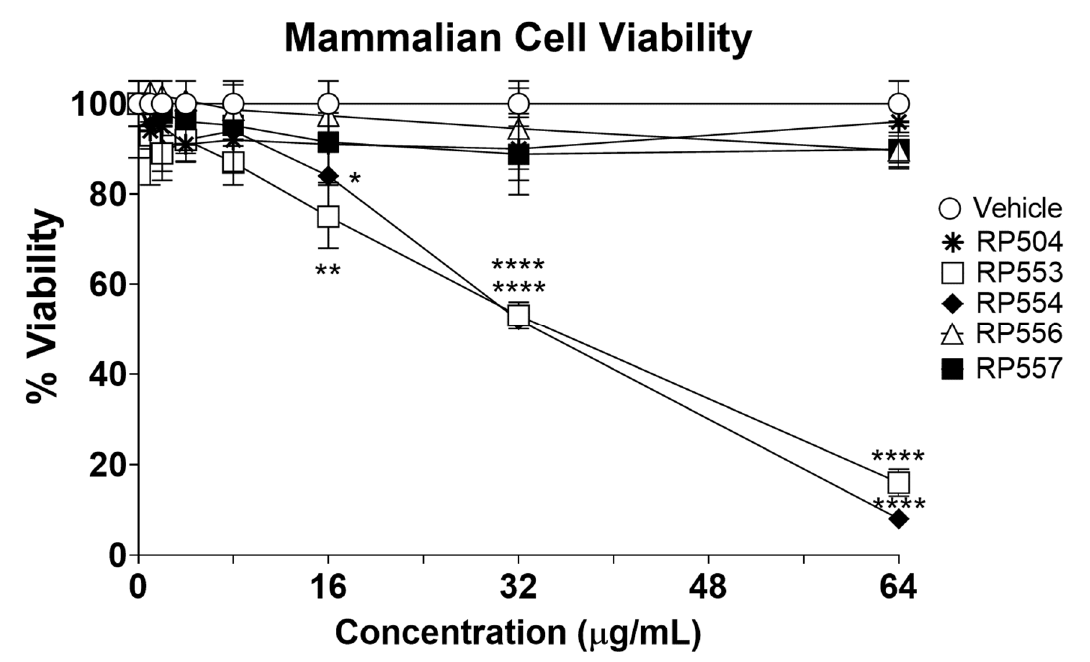
Figure 2. RP504, RP556 and RP557 induce limited mammalian cell toxicity. Concentration dependent